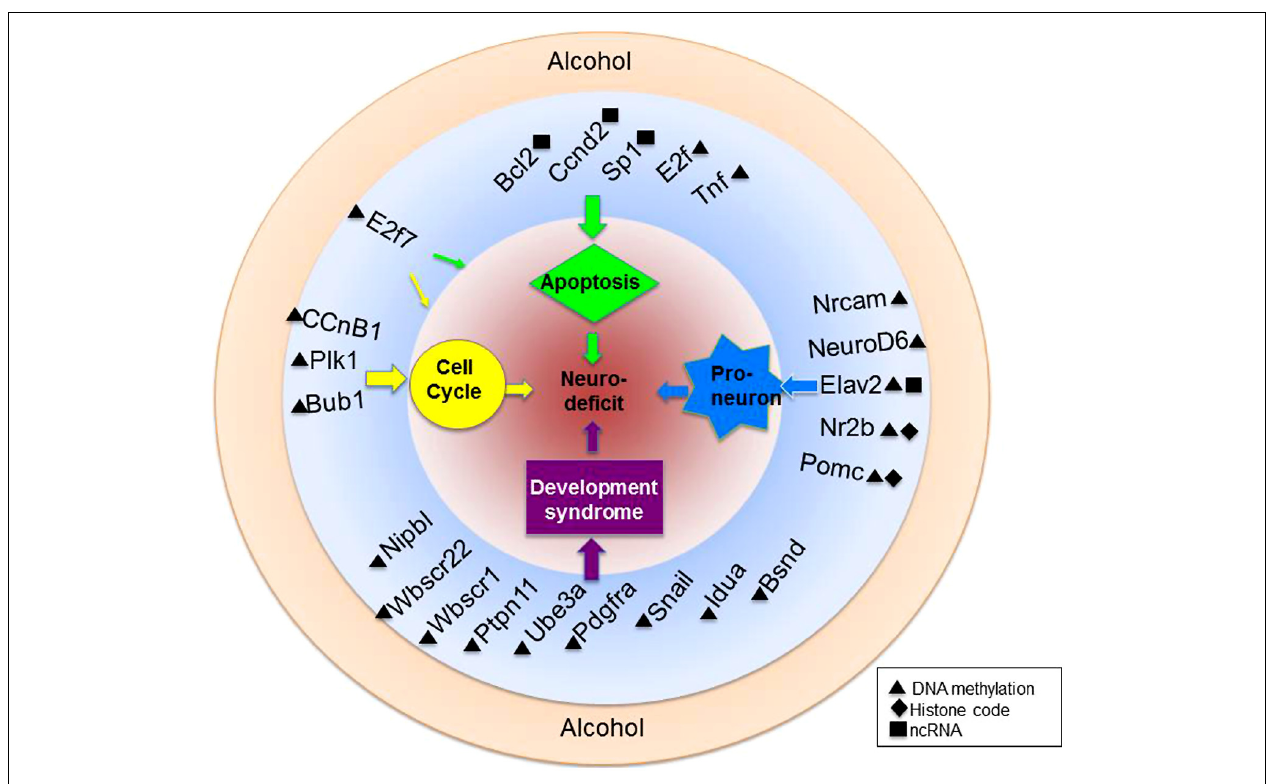
FIGURE 3 |Alcohol-mediated epigenetic targets of neural development. Alcohol is a teratogen with known capabilities to alter the epigenome. Highlighted here are just a fraction of genes within various biological pathways of known vulnerability to